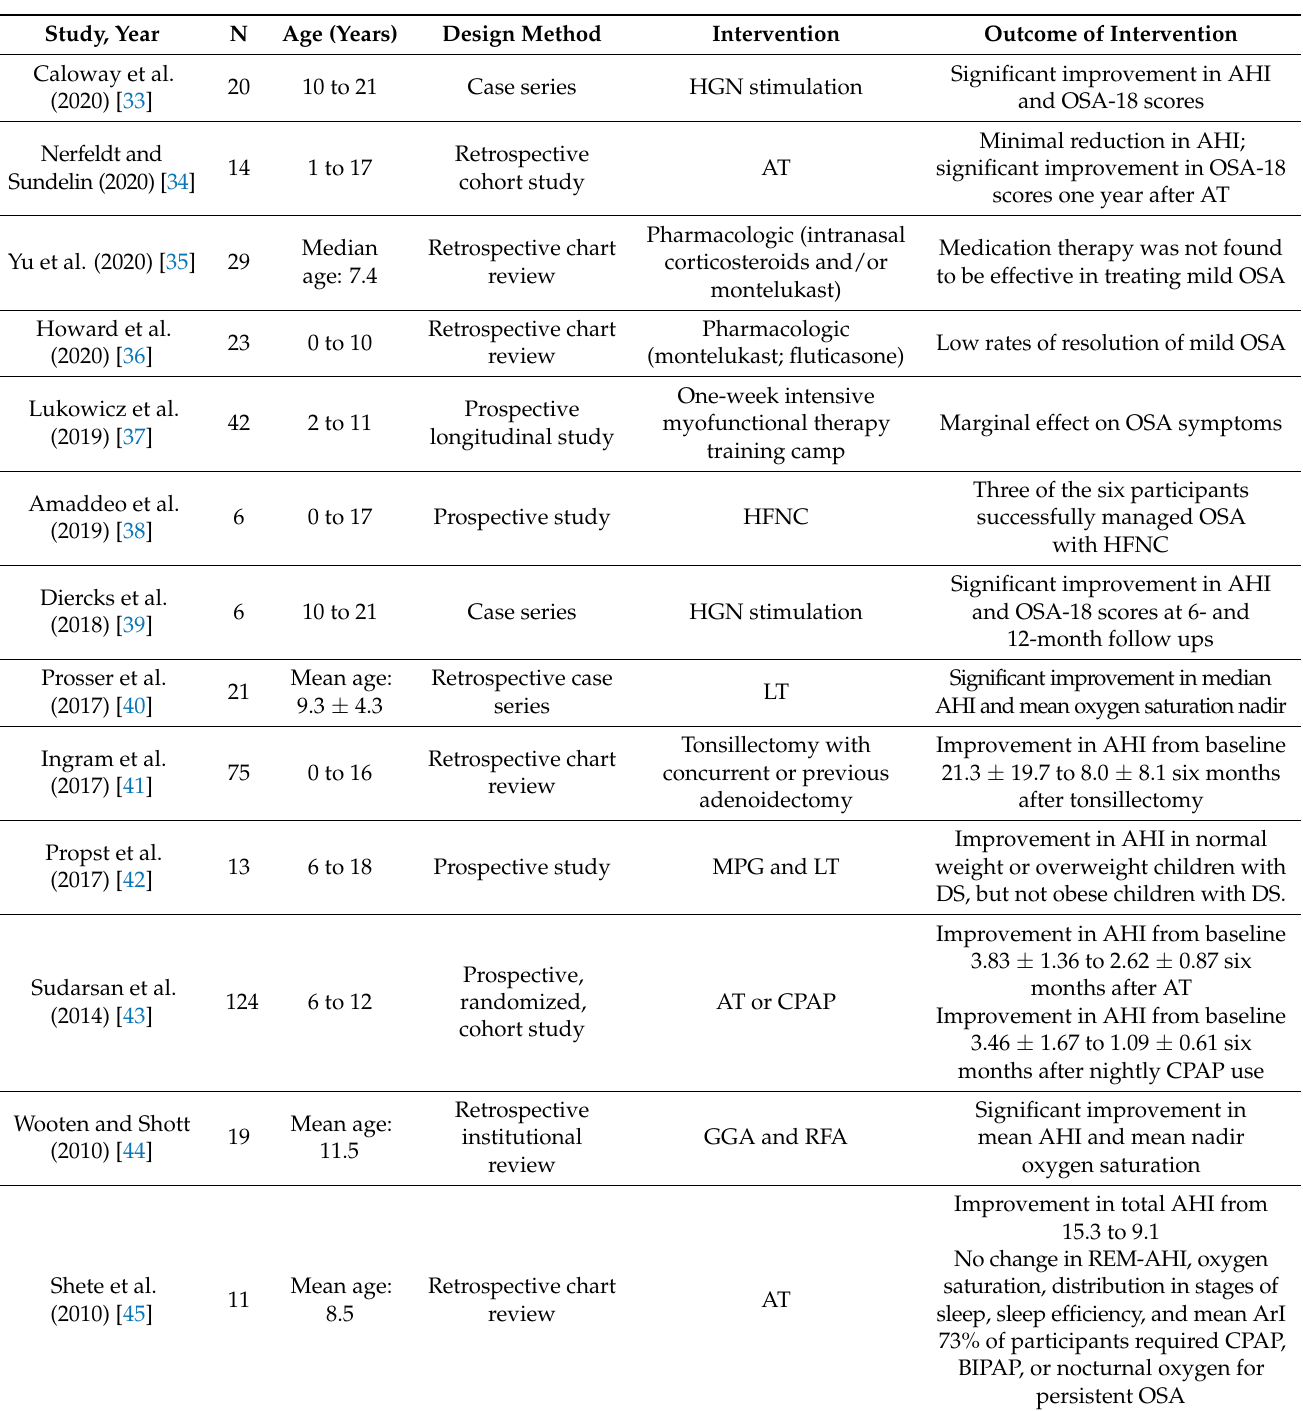
Table 1. Outcomes of interventions in studies of obstructive sleep apnea in pediatric Down